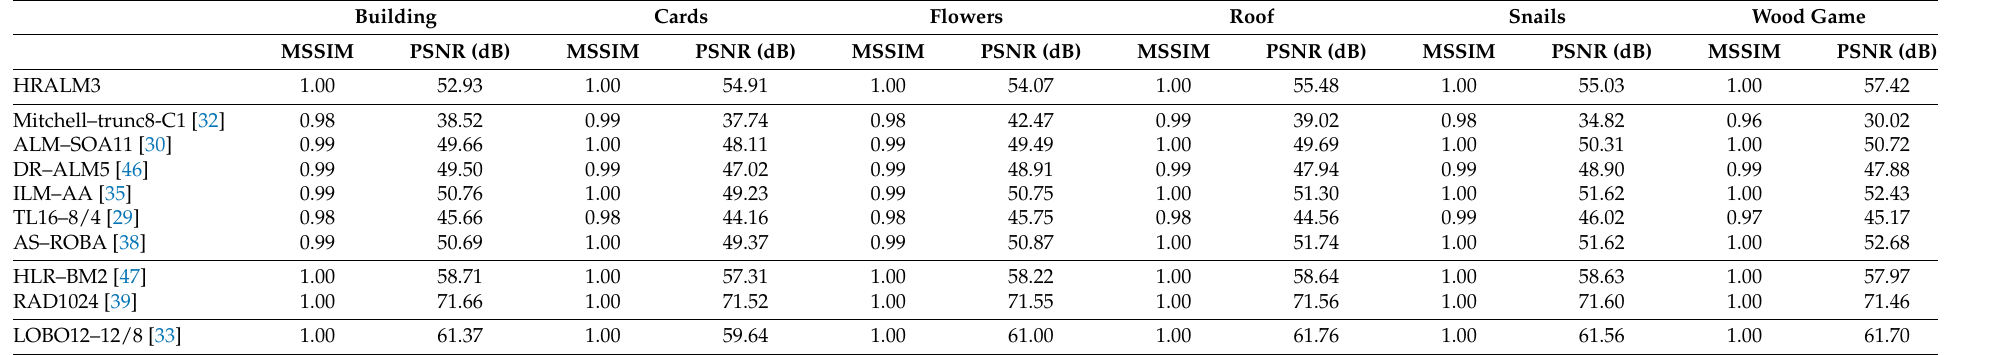
Table 4. The MSSIM and PSNR metrics for image